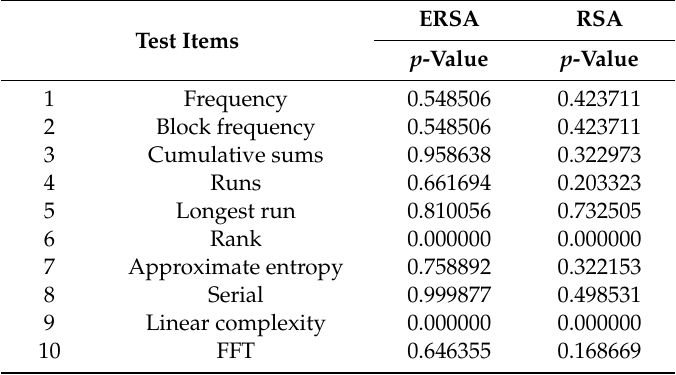
Table 2. NIST test